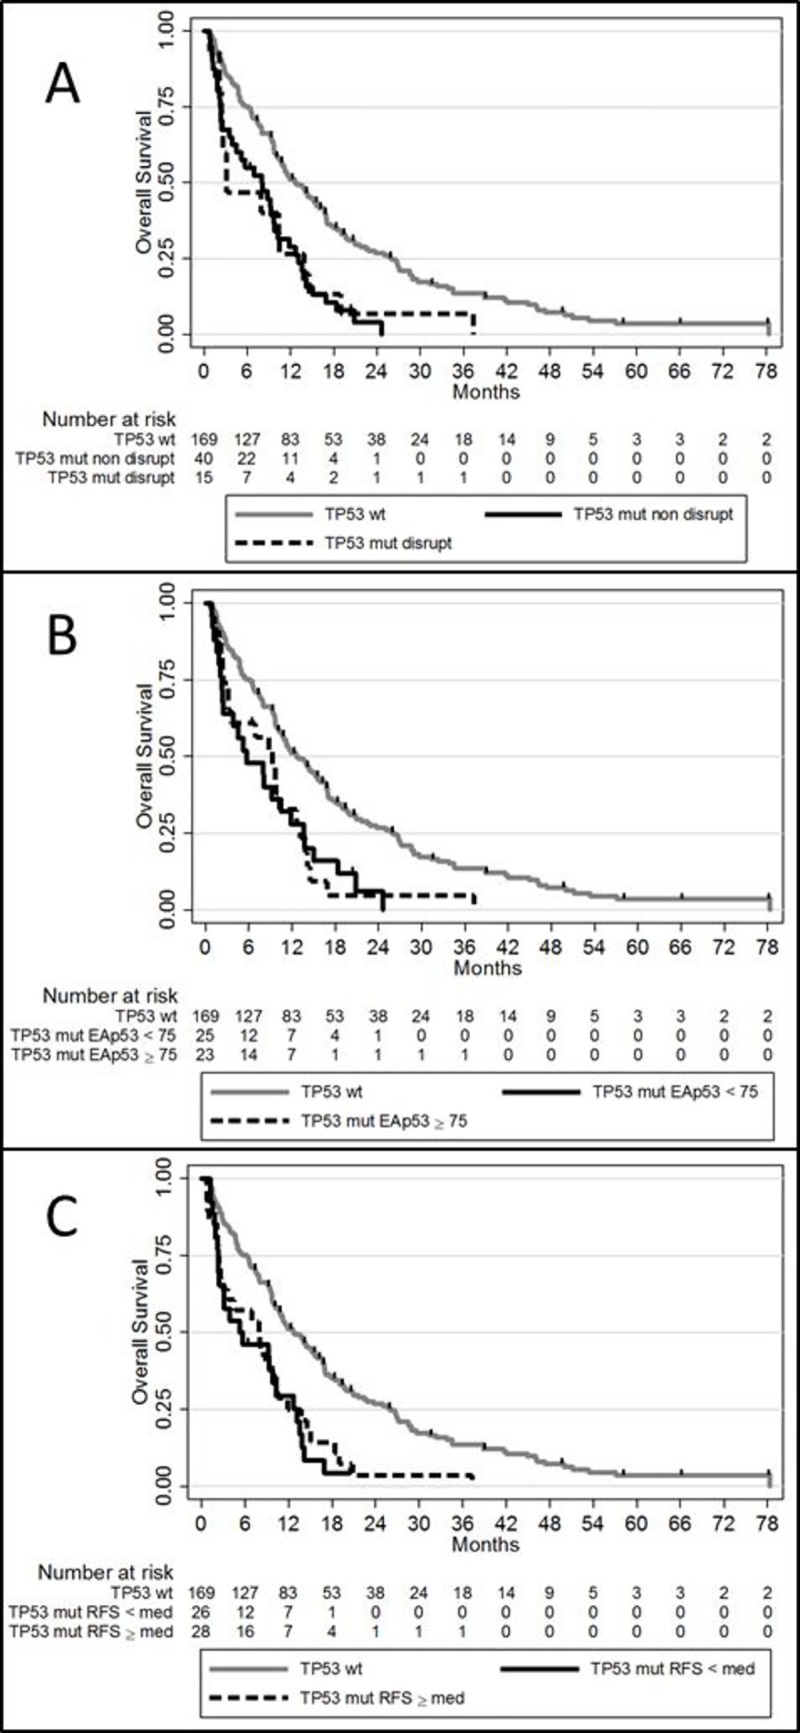
Overall survival according to TP53 mutations classifications.A. OS according to TP53 disruptive classification: disruptive TP53 mutation versus non-disruptive TP53 mutation versus TP53wt. B. OS according to evolutionary action score: EAp53 < 75 versus EAp53≥ 75 versus TP53wt. C. OS according to relative flexible score: RFS < median versus ≥ median versus TP53wt.